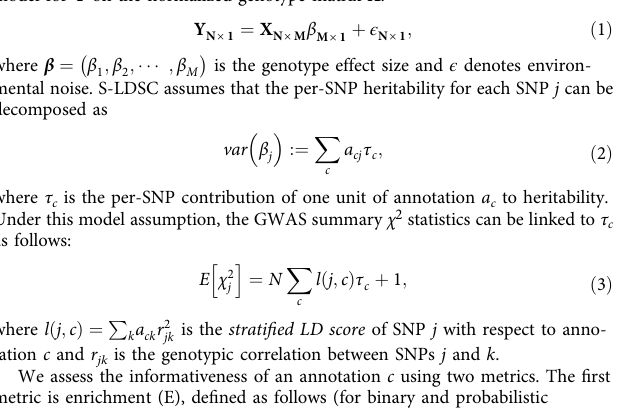
average (Avg) or maximum (Max) across tissues. ● (Supplementary Table 33) 12 annotations consisting of CpG-island, local CpG-content and local GC-content annotations, as well as these annotations restricted to coding, repressed and TSS regions (for which BiClassCNN produced conditionally signi fi cant signals). The CpG-island annotation was retrieved from the UCSC genome browser 52 . Local CpG-content and local GC-content denote the proportion of CpG and G + C dinuclotides in ±1 kb regions around each variant of the genome, computed using the hg19 reference genome fasta fi le. By de fi nition, the LocalGCcontent annotation is of larger size than the LocalCpGcontent annotation. ● (Supplementary Table 33) 3 annotations consisting of a pLI annotation, as well as this annotation restricted to coding and TSS regions. The pLI annotation was de fi ned by annotating each SNP in a 5 kb window around a gene with the pLI score of that gene 53 . We did not consider the pLI annotation restricted to repressed regions because unlike TSS and coding, repressed regions are not directly linked to a gene. ● (Supplementary Table 33) 2 coding annotations, SIFT 54 and Polyphen 55,56 , which have been analyzed in previous work 57,58 . Strati fi ed LD score regression . Strati fi ed LD score regression (S-LDSC) is a method that assesses the contribution of a genomic annotation to disease and complex trait heritability 5,19 . Let a cj be the value of annotation c for SNP j , where a cj may be binary (0/1), continuous or probabilistic. S-LDSC assumes a